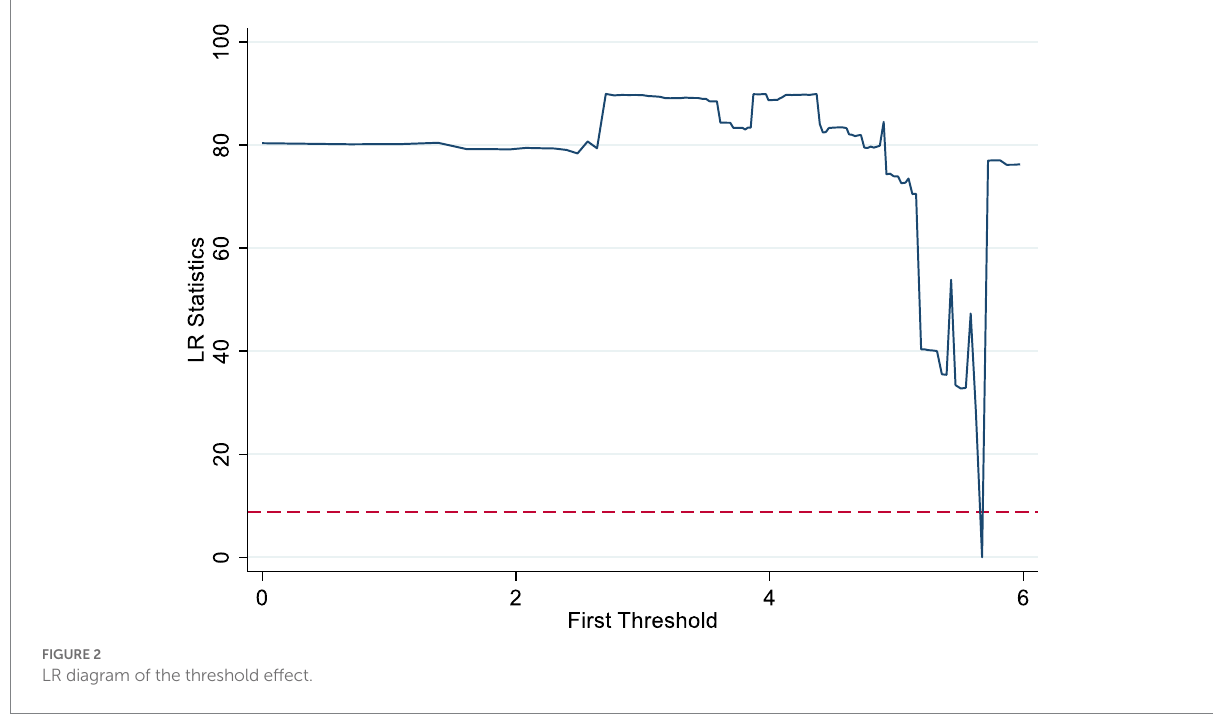
FIGURE 2 LR diagram of the threshold